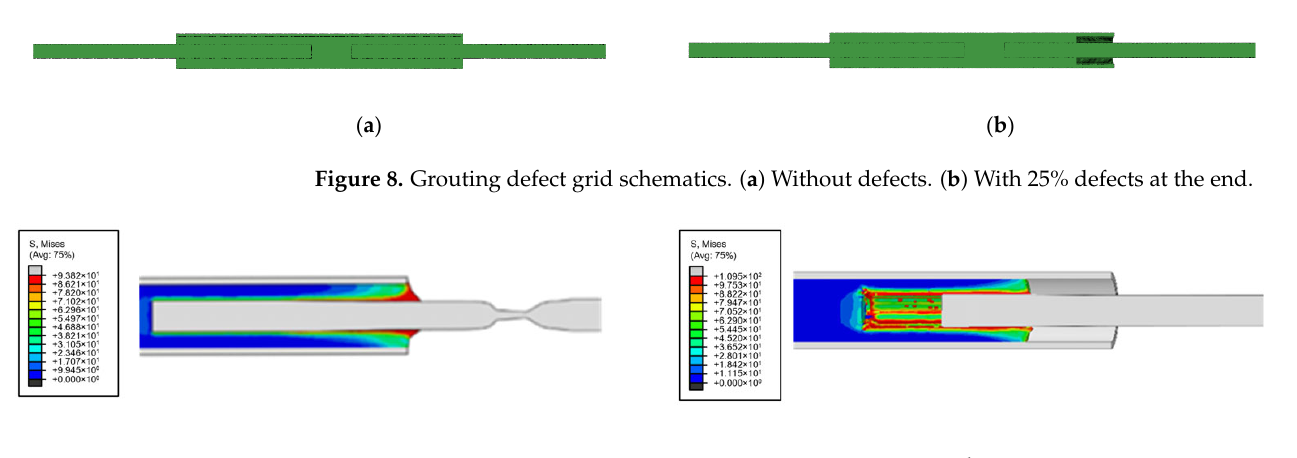
Figure 9. Failure modes of the grouting sleeves without and with defects. ( a ) Without defects.